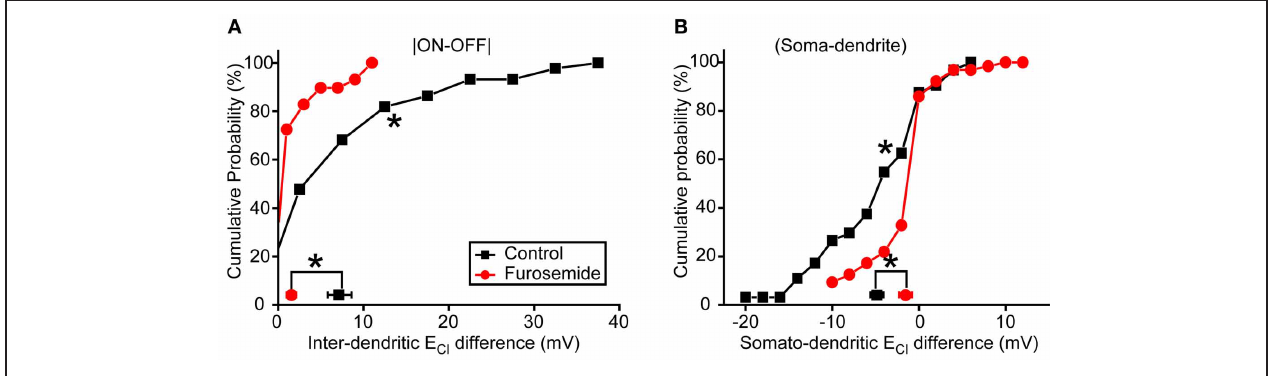
animals. The symbols near the X-axis represent the mean E Cl differences. ∗ P < 0 . 01, Kolmogorov–Smirnov test. The values are represented as mean ± SEM.